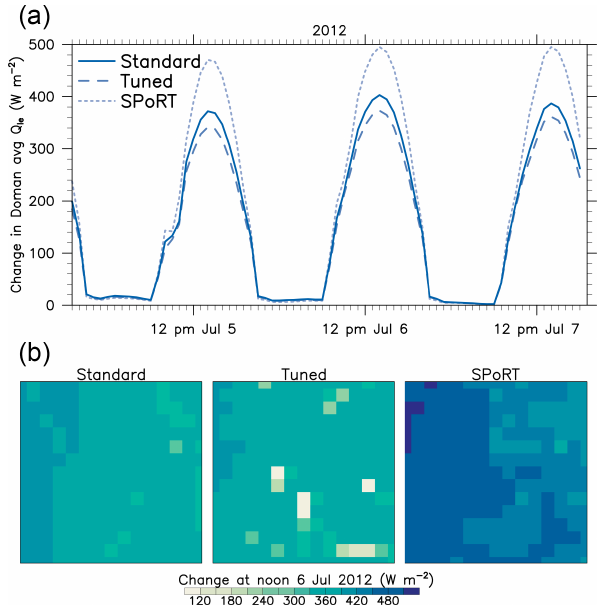
Figure 6. (a) Domain average difference (i.e., each irrigation run minus Control) in latent heat flux for three diurnal cycles in July 2012 (b) . Difference in latent heat flux at noon on 6 July